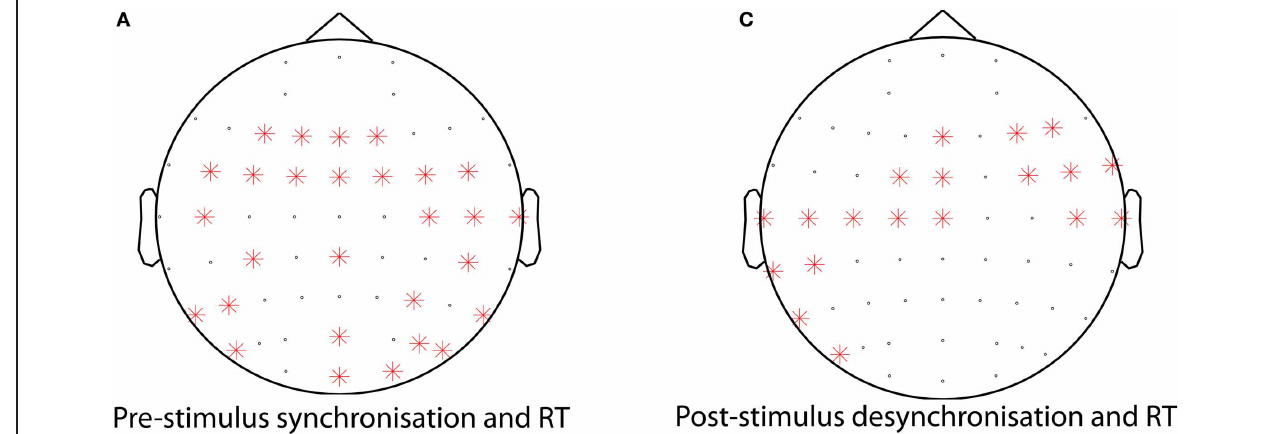
subgroup with the slowest reaction-times. The black rectangle depicts the time-window where there is a significant difference between the two groups (point-by-point t -tests, p < 0 . 05). (C) Electrodes highlighted with red stars are electrodes where reaction-time correlated with level of desynchronization, such that a greater decrease in normalized alpha power correlated with a faster reaction-time. ( p < 0 . 05, cluster corrected). Desynchronization is defined as average from 200ms to 500ms after stimulus offset divided by average from 500ms to 200ms before stimulus onset. Purple vertical line at 0 marks stimulus